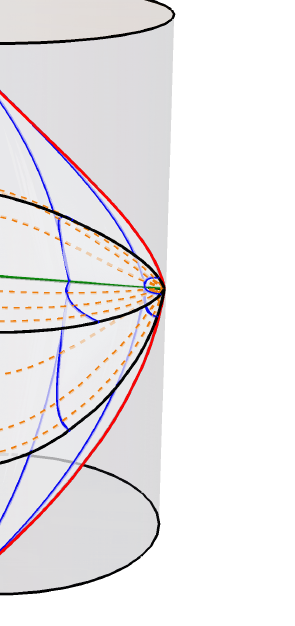
Figure 27 . The planar and compact (static) BTZ black holes. Lines of constant φ are shown in blue, with lines of constant r in dashed orange. Several surfaces of constant time t are shown. The classically accesible subset of the boundary is bounded in red. To guide the eye, the locus of the cylinder is shown in solid black. (a): φ ∈ R , giving the planar BTZ geometry or “Rindler wedge”. The bifurcation surface (green) has topology R . (b): φ identified with period 2 π , giving the BTZ black hole. Lines of constant t and φ = ± π are plotted in long-dashed black, pairs of which are identified across the same time-slice. The bifurcation surface (green) has topology S 1